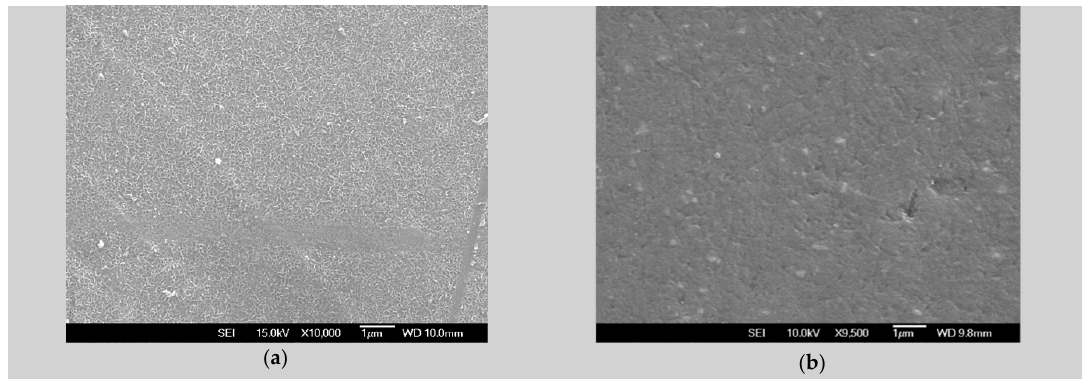
Figure 1. SEM micrographs of uncoated alloysamples: ( a ) ZM21 plain view, magnification 10,000 × ; ( b ) ZMX410 plain view, magnification 9500 ×